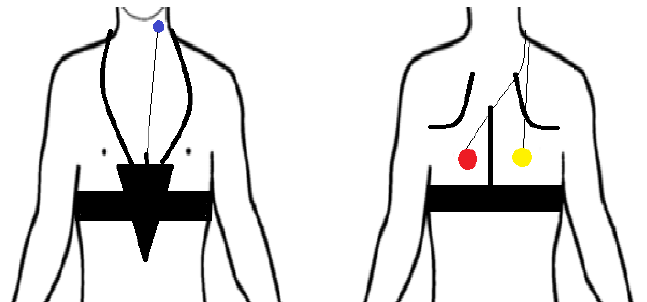
Figure 1. Setup of trachea and lung bio-acoustical microphones for the LEOSound ® cough recording. Hourly Cough Rate (HCR) Hourly cough rate (HCR) was presented in a numerical form.